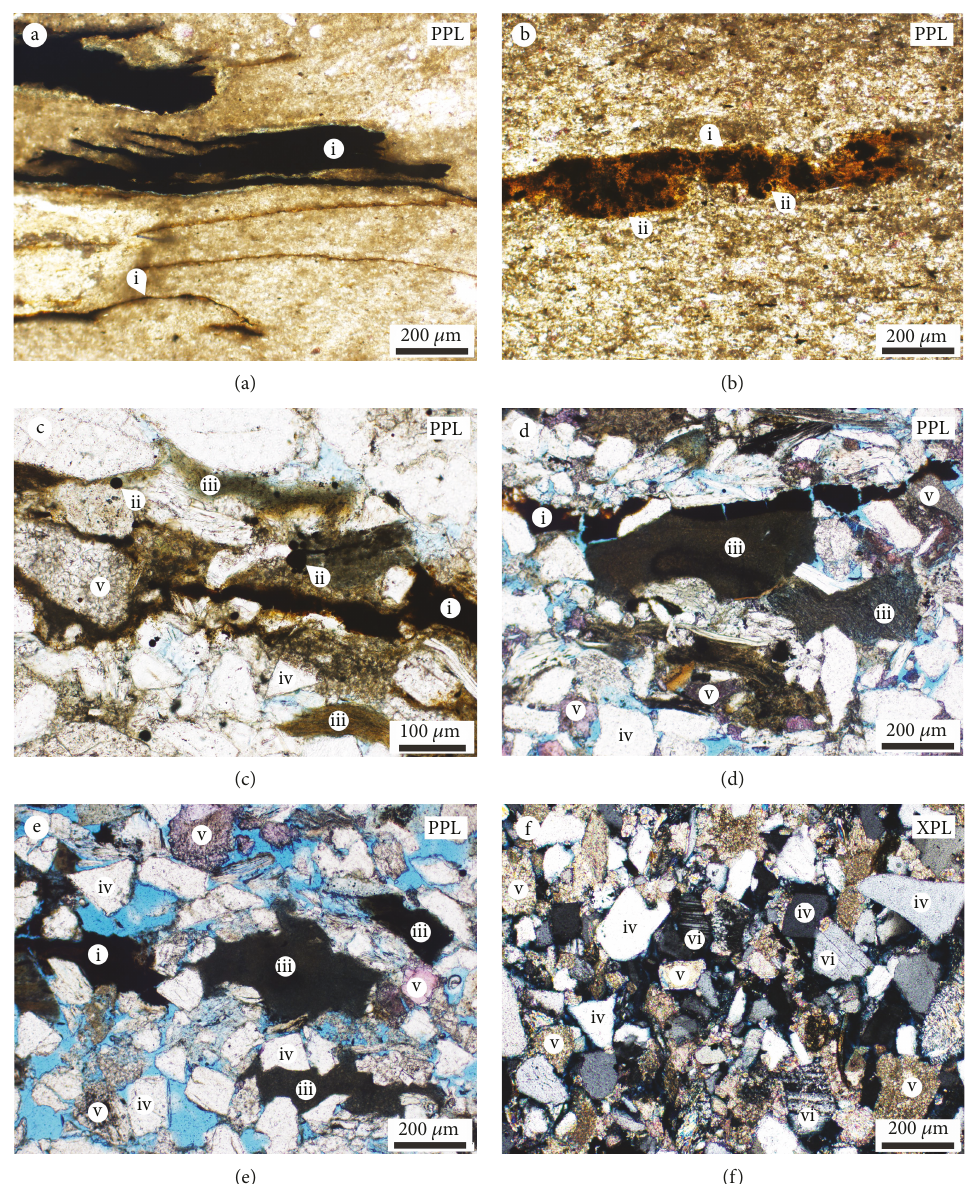
Figure 7: Micropetrographic characteristics of the studied mudrock and sandstone samples (a: 1/7; b: 1/10; c – e: 1/4; f: 1/3). (a, b) Textural features of the marl samples, including oriented organic matter fragments (i). Note enrichment of framboidal pyrites (ii, “ black spots ” ) in a close relationship with organic matter. (c – f) Silt- to sand-sized detrital grains together with organic matter (i) seams and reworked mudrock (iii) fragments in sandstones. Intergranular pores are fi lled by blue epoxy resin. Dominant framework grains: quartz (iv), carbonate lithics (v), and plagioclase feldspar (vi). Abbreviations: PPL=plane polarized light; XPL =crossed